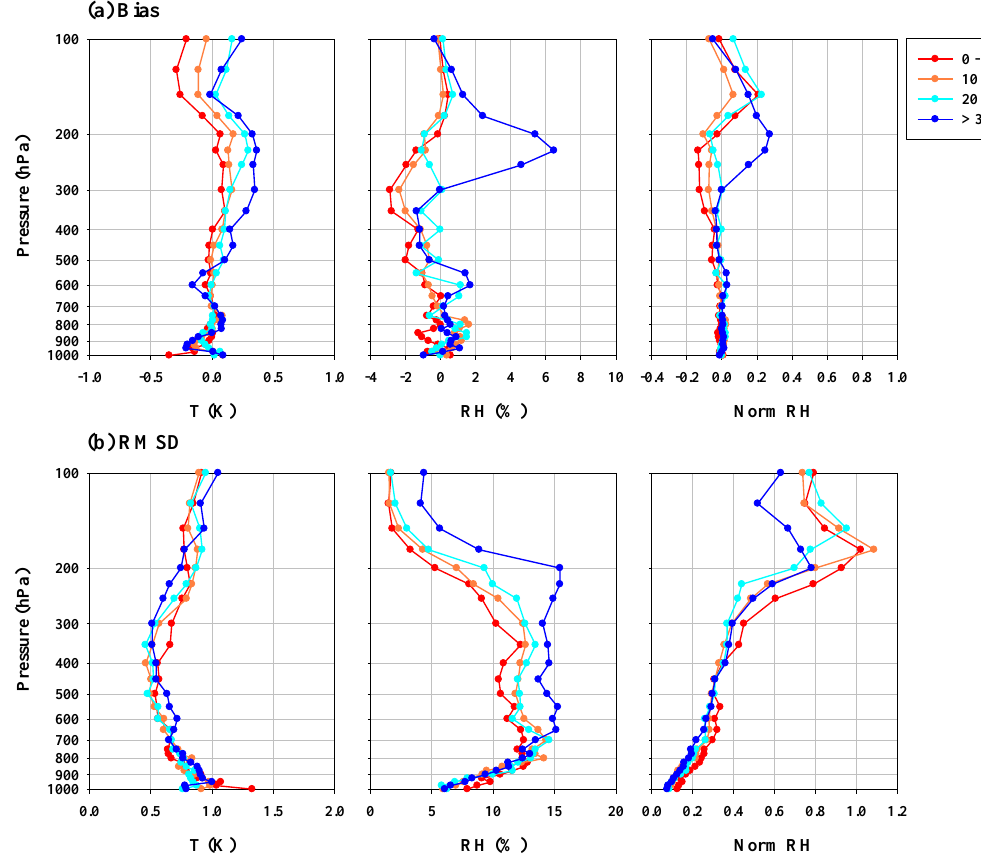
Figure 5. Error statistics of the Korea Meteorological Administration model (UM-KMA) temperature and relative humidity profiles classified according to the total precipitable water between the surface and 100 hPa (TPW, in kg·m −2 ). ( a ) Bias and ( b ) RMSD.